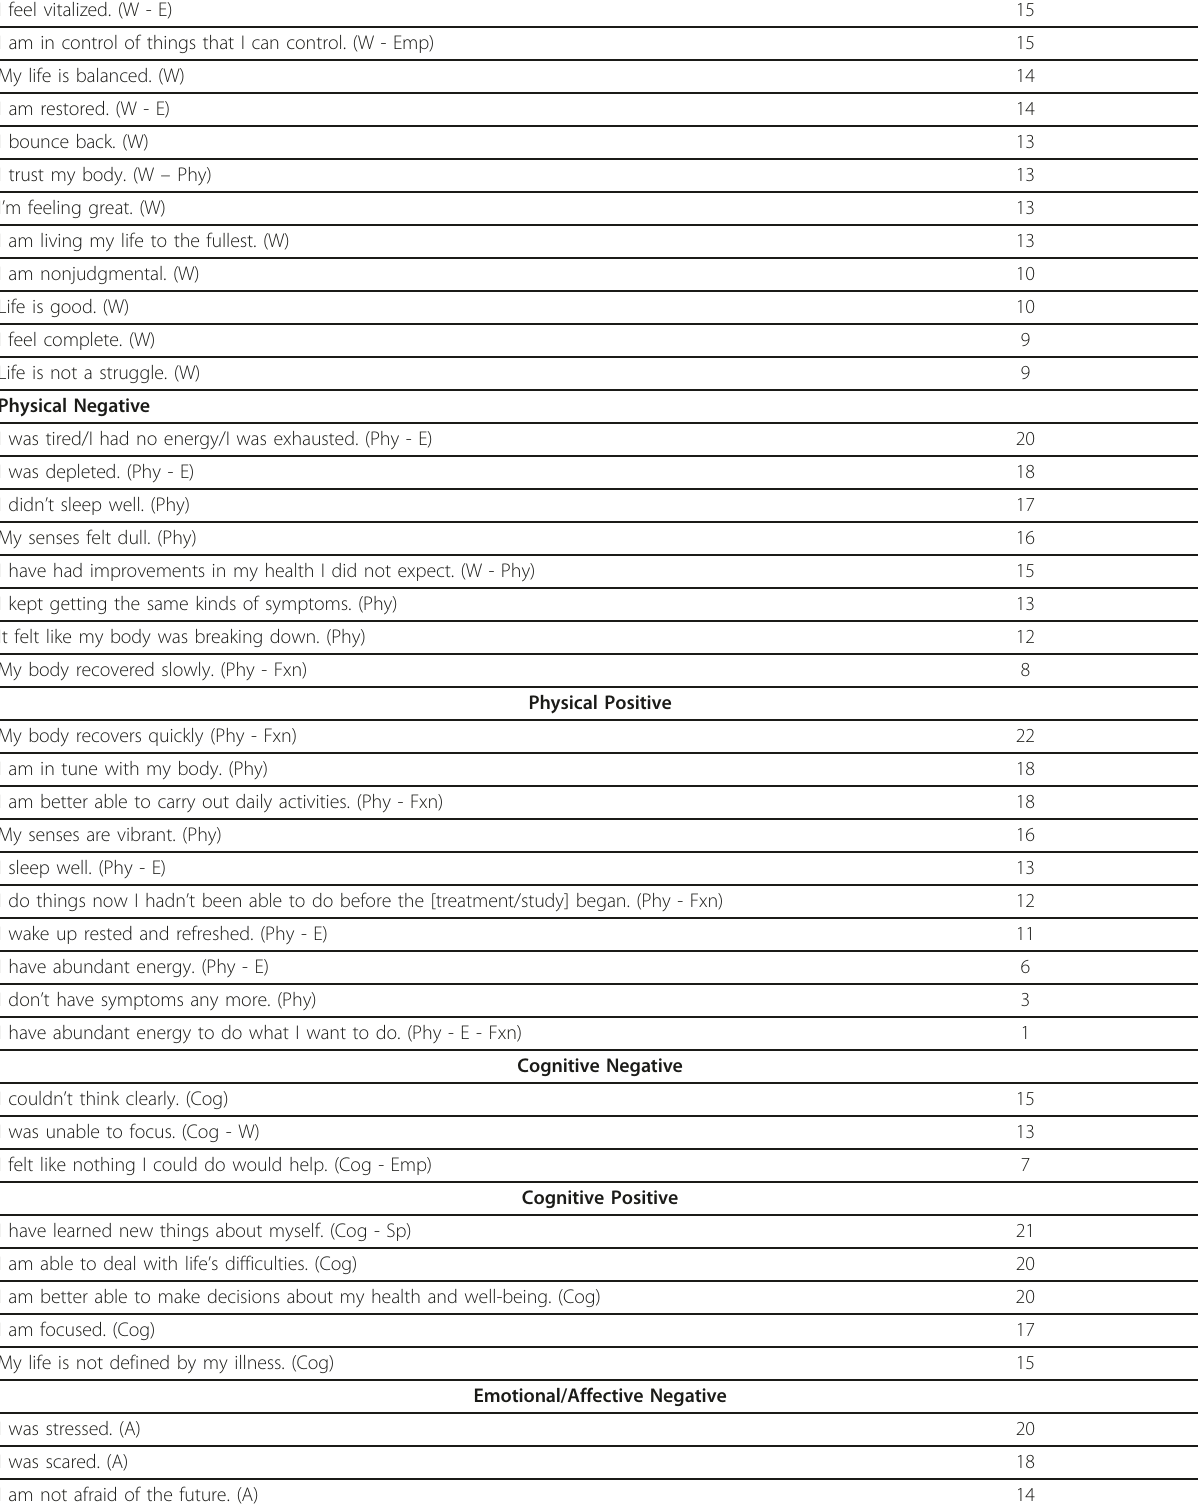
Table 4 Complete List of Positive and Negative Items by Level of Endorsement* Sorted by Psychometric